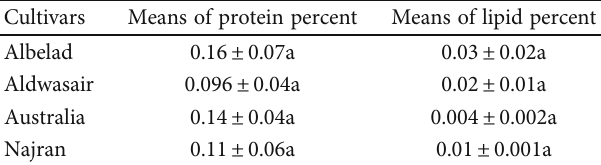
Table 2: Protein and total lipid estimation.